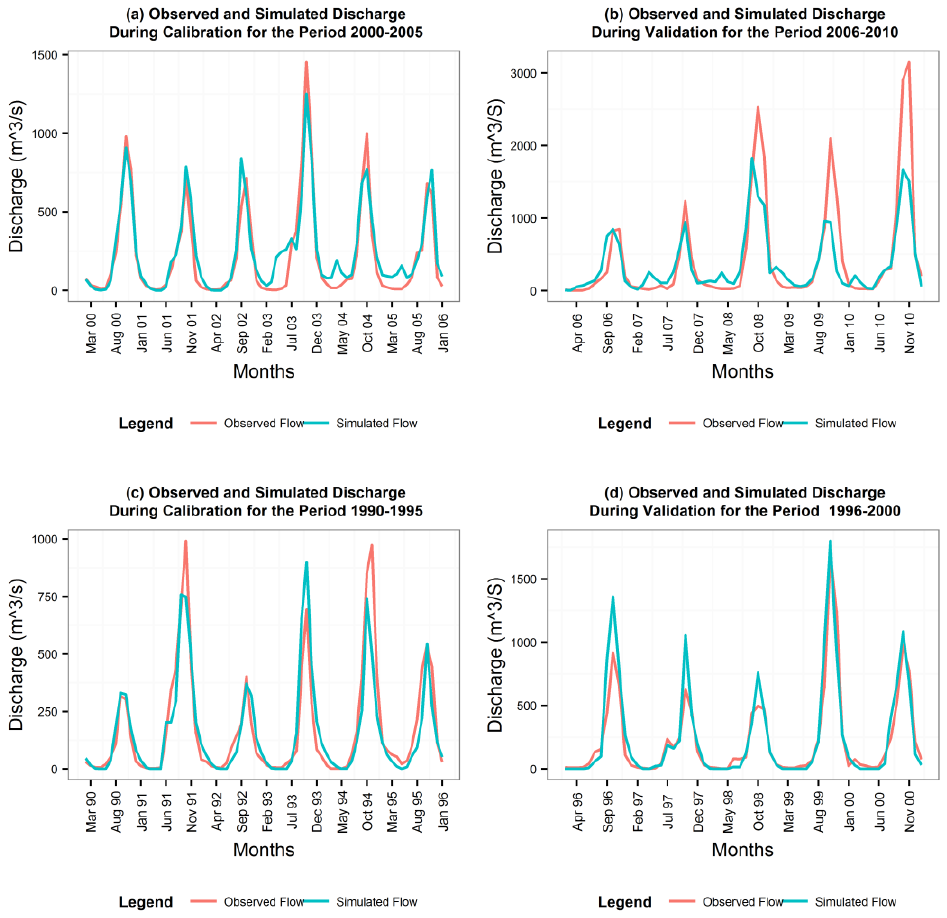
Figure 7. Discharge during Calibration and Validation.